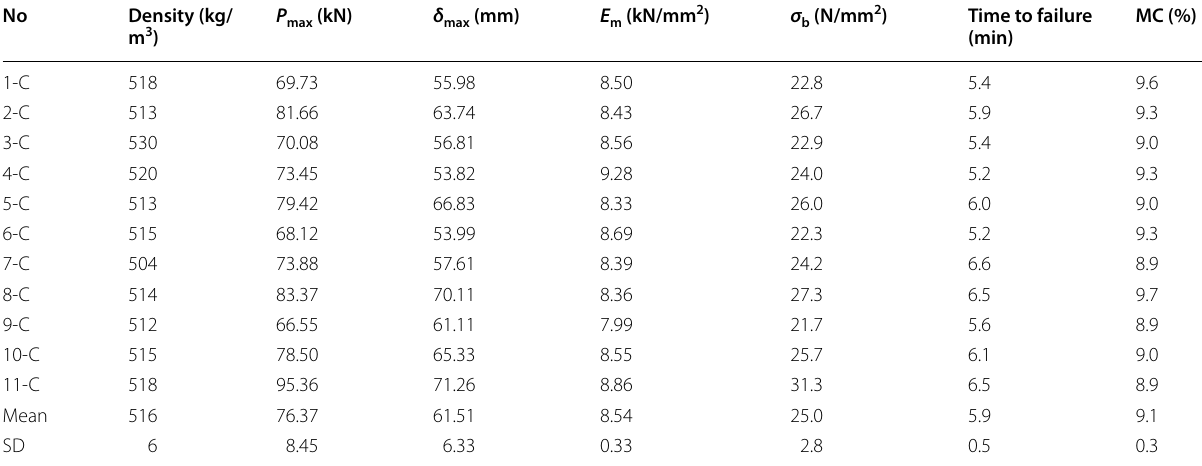
Table 1 Results of the short-term loading